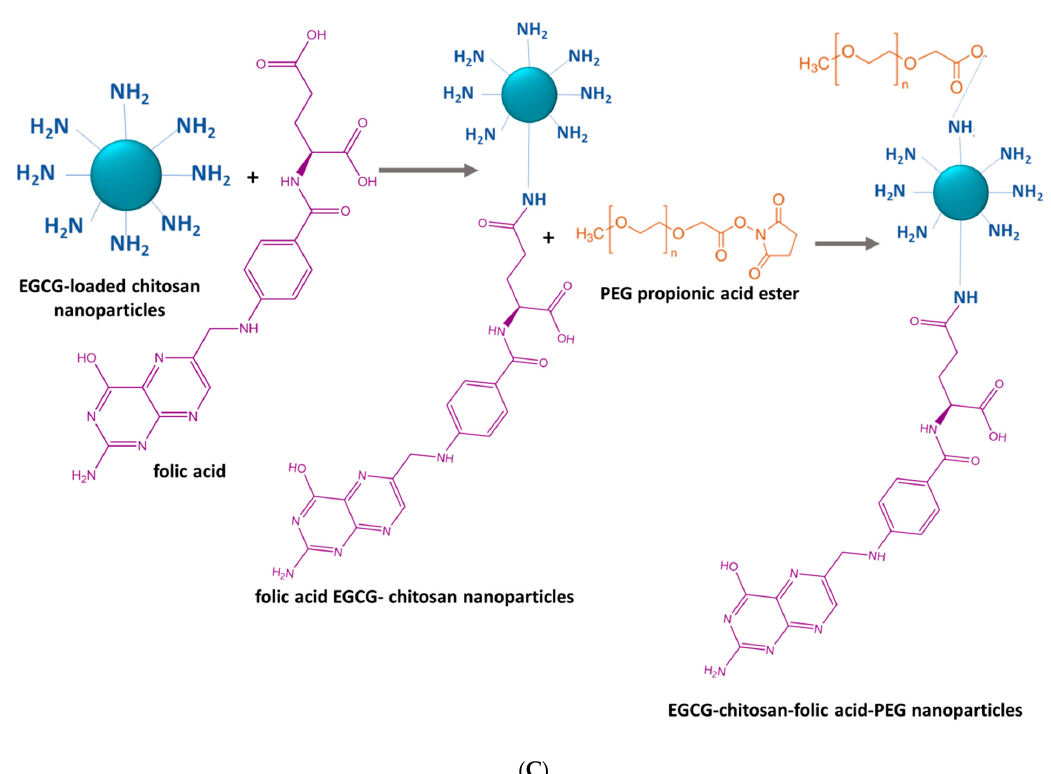
Figure 4. Synthesis mechanism of epigallocatechin gallate (EGCG)-loaded chitosan-folic acid-PEG and chitosan-poloxamer nanoparticles: ( A ) synthesis of EGCG-chitosan nanoparticles with Na-tripolyphosphate, ( B ) modification of EGCG-chitosan nanoparticles with poloxamer, ( C ) synthesis of EGCG-chitosan-folic acid-PEG nanoparticles via two consecutive reactions with folic acid and PEG propionic acid ester (Adapted from References [45–47]).